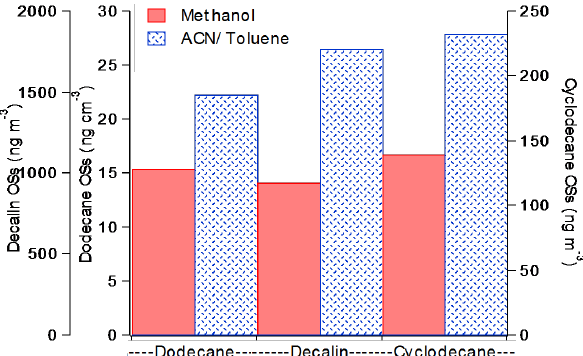
Figure 6. Impact of extraction solvent composition on quantification of identified OSs from gas-phase oxidation of alkanes.